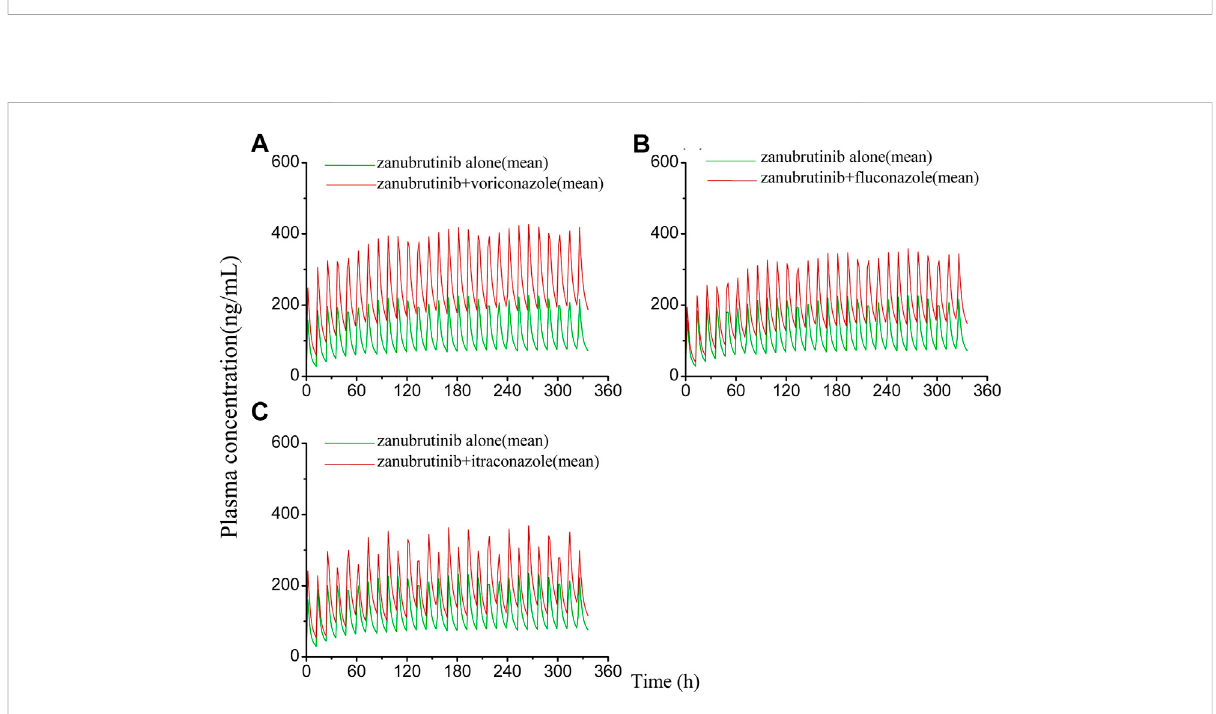
FIGURE 5 Simulated plasma concentrations of multiple doses (14 days doses) of zanubrutinib (160 mg twice daily) dosed alone or concomitant with (A) voriconazole (400 mg twice-daily (day 1) and a subsequent dose of 200 mg twice-daily); (B) fl uconazole (200 mg once daily); (C) itraconazole (200 mg once